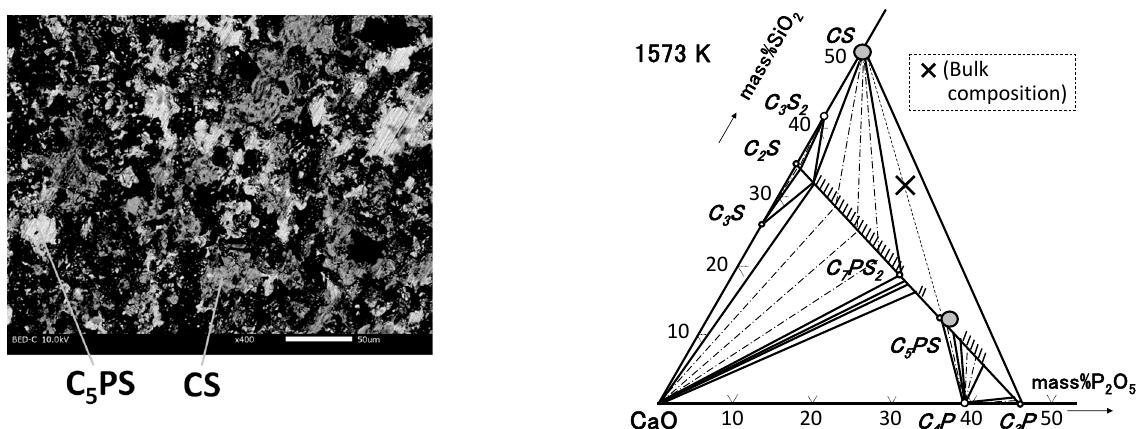
Figure 5. SEM image of M3-0 ( left ) and phase composition projected on an isothermal section of the CaO-SiO 2 -P 2 O 5 ternary phase diagram at 1573 K ( right ). Table 3. Compositional analysis of the observed phases in the ternary samples (in mass%). Sample No.